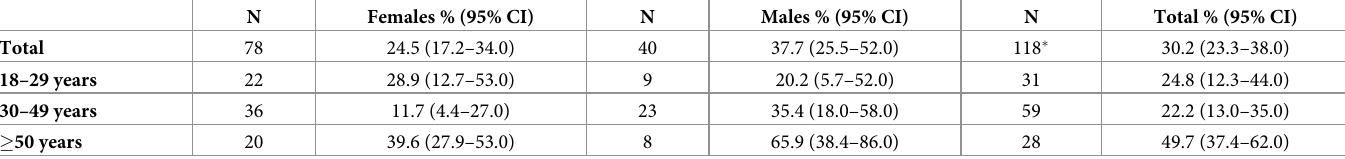
CI, confidence interval. � One infected individual did not respond the symptoms